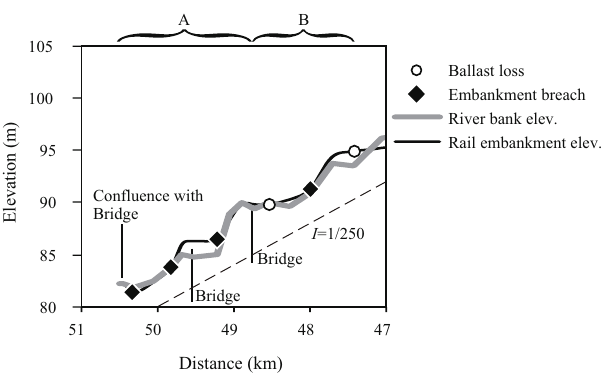
Figure 16. Longitudinal profiles of railway and riverbank eleva- tion. The cross sections where the river and railway intersect are indicated as “bridge” (Tsubaki et al.,